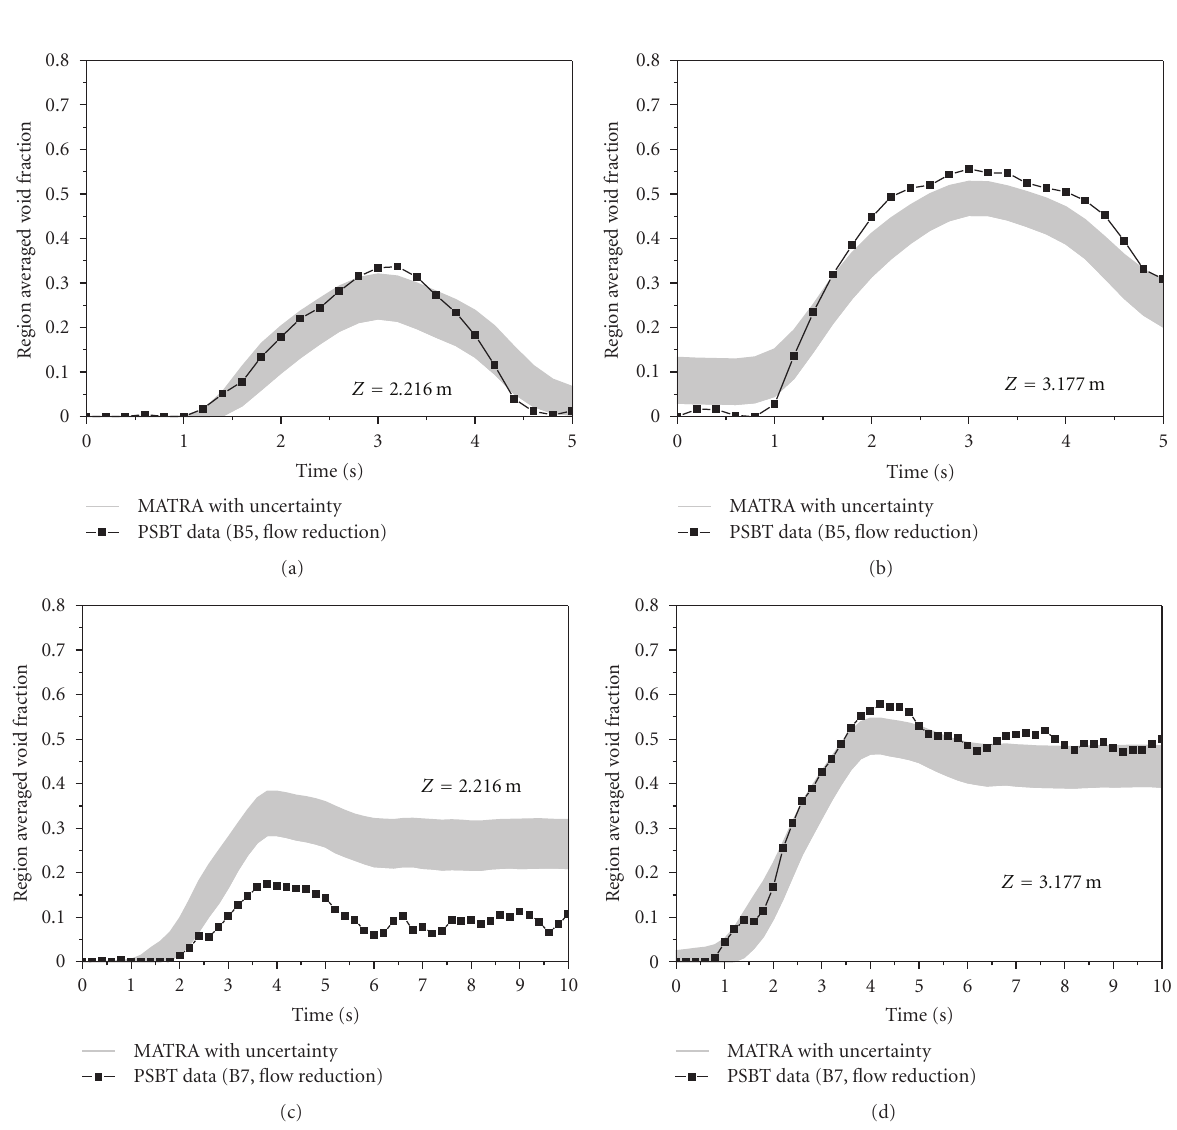
Figure 5: Uncertainty of subchannel void prediction for flow reduction transients.